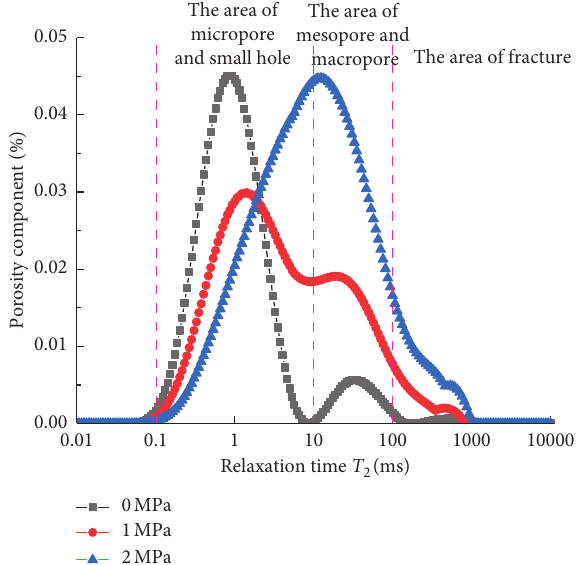
Figure 19: The T